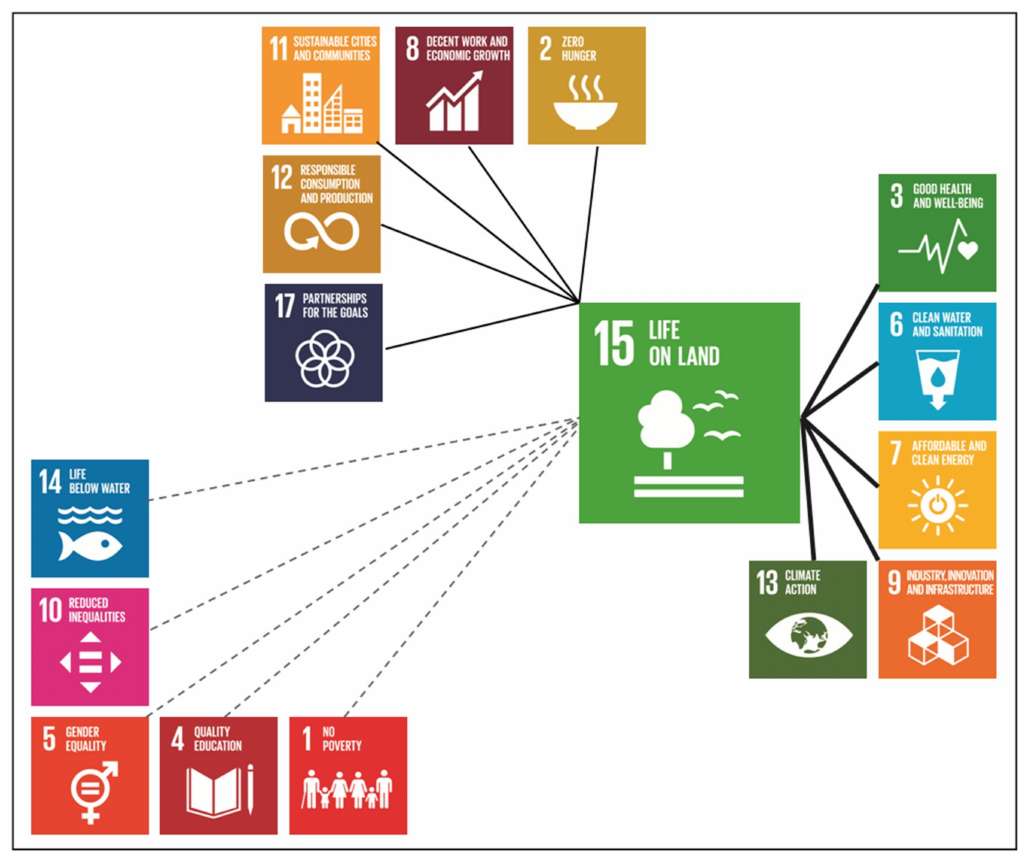
Figure 1. Interrelations between SDG15 (Life on Land) and other SDGs. The length and width of the lines relate to the apparent closeness of the SDGs with